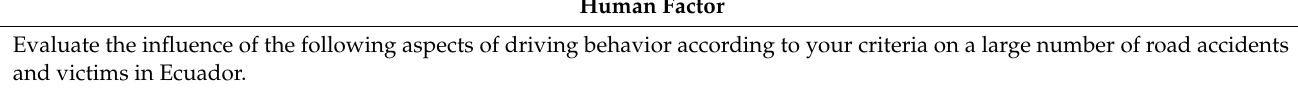
Table 3. Questionnaire and construct